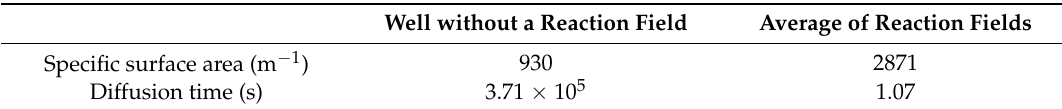
Figure 7. Fluorescence intensities of IgA ELISA in relation to HRP-IgA incubation time for wells without and with the film-stack reactions with the micro-pillars array having different dimensions. The trial number of experiments is three. Error bars are the maximum and minimum intensities. Table 3. Specific surface areas and diffusion times.